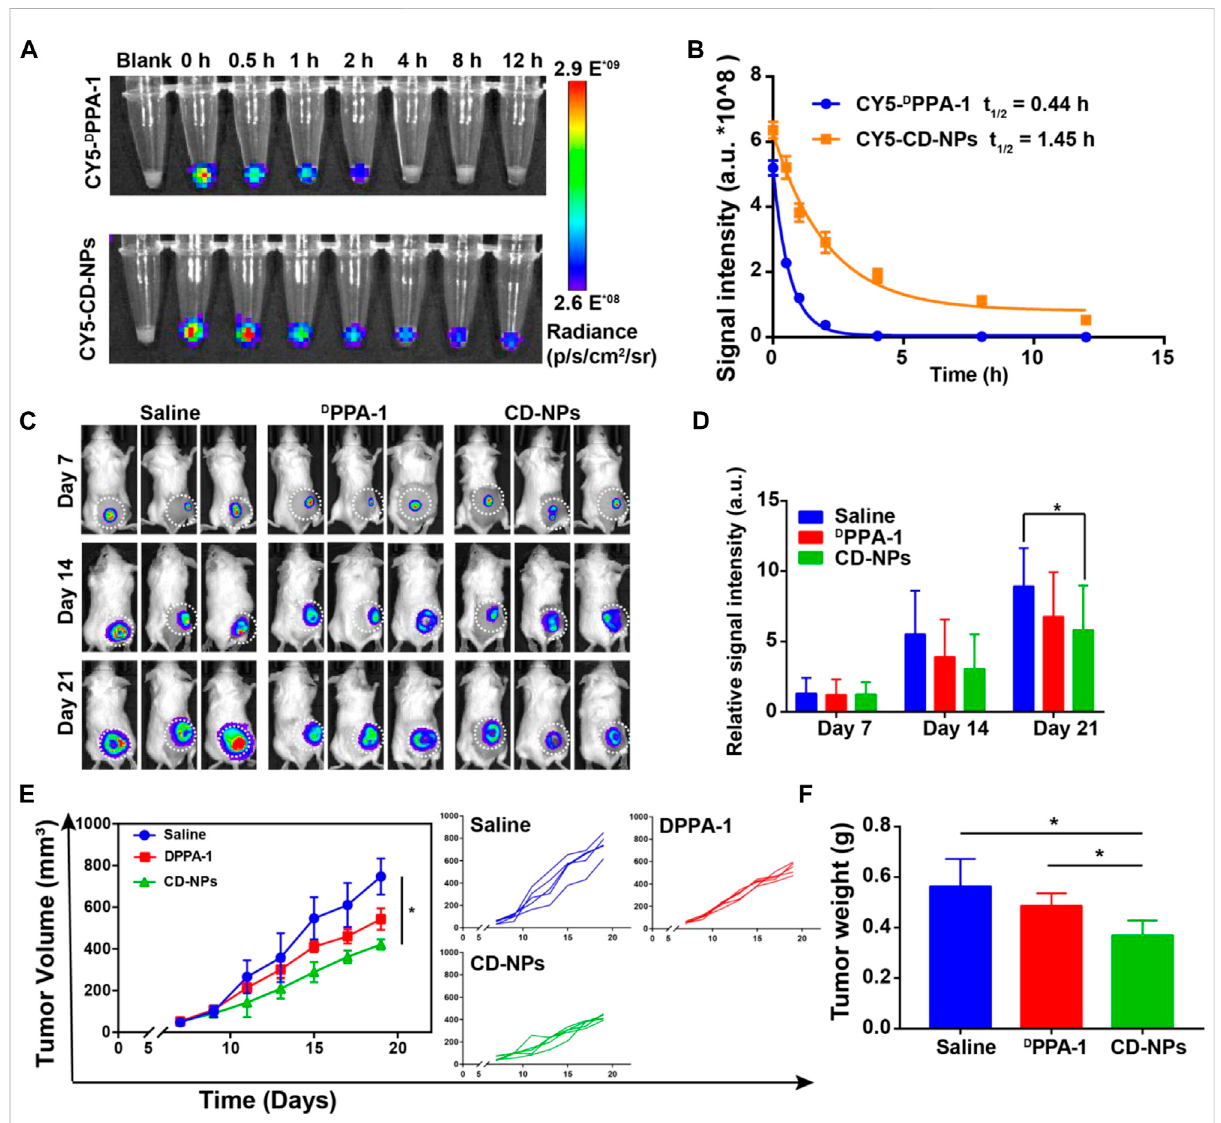
Pharmacokinetics and antitumor effects of CD-NPs in vivo . (A) Fluorescence images and (B) semi-quantitative analysis of blood collected at indicated time points from 4T1-luci tumor-bearing mice injected with CY5-labeled D PPA-1 or CD-NPs ( n = 3). (C) Bioluminescence images and (D) correspondingsemi-quantitativeanalysisof4T1-lucitumor-bearingmiceatindicatedtimepointsaftertreatmentwithdifferentformulations( n =3). (E) Growth curves of tumors from mice treated with various formulations. (F) Tumor weights of mice treated with various formulations ( n = 5). * p <